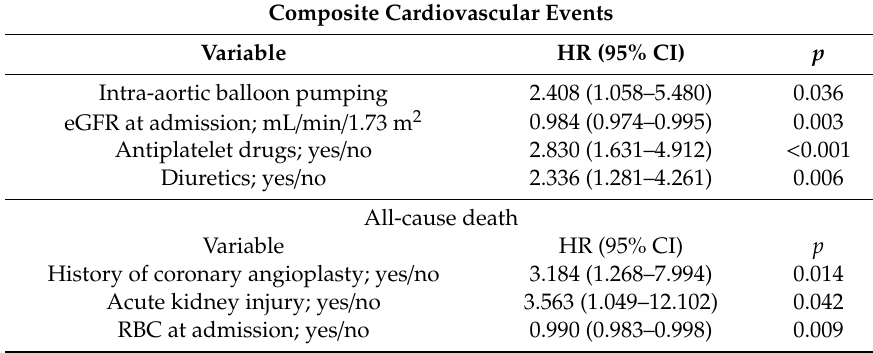
Table 3. Analysis of Cox proportional hazards model with stepwise variable selection for prediction of adverse events in non-STEMI without elevated CK (NSTEMI-CK). eGFR: estimated glomerular filtration rate, RBC: red blood cell